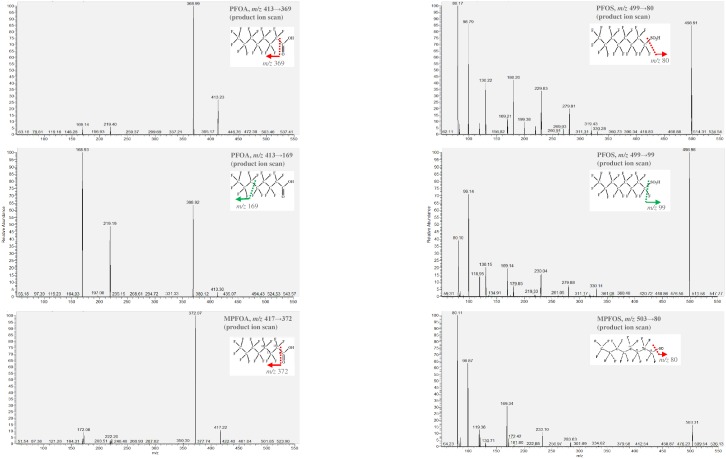
Product ion scan of perfluorooctanoic acid (PFOA) and perfluorooctane sulfonate (PFOS).